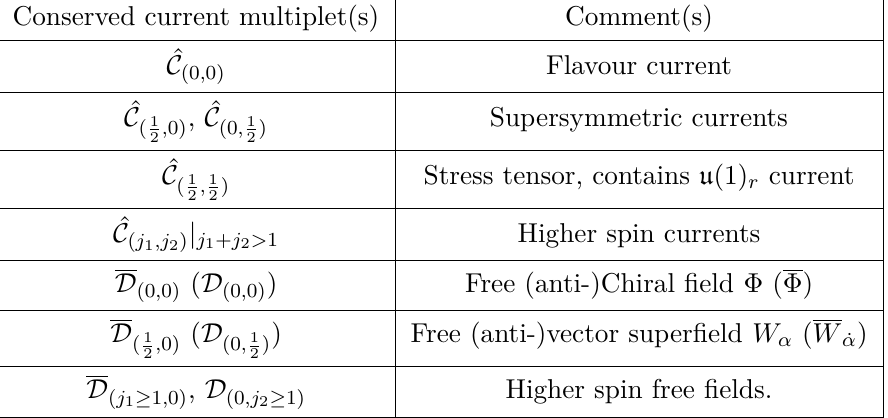
Table 15. Conserved current multiplets of su (2 , 2 | 1) superconformal algebra.